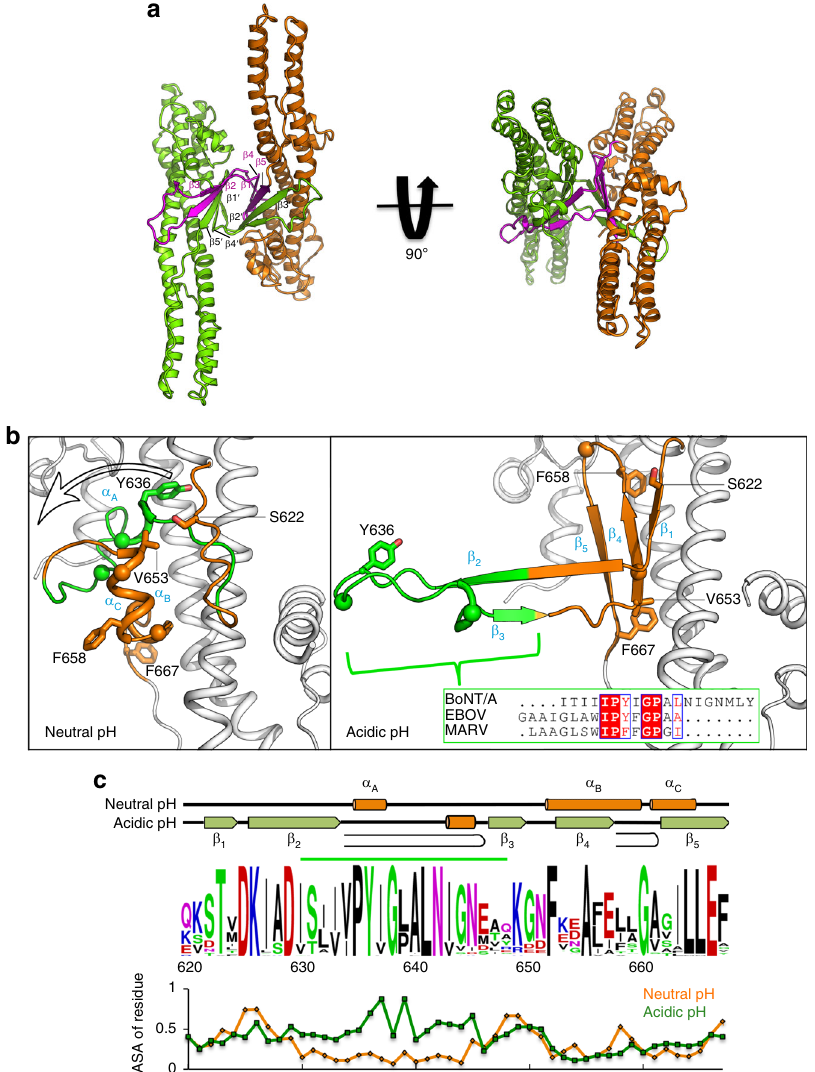
Fig. 2 Crystal structure of tH N A at an acidic pH. a Structure of a tH N A dimer (orange and green) observed in an asymmetric unit. The BoNT-switch of chain A is colored in magenta. b The structures of the BoNT-switch at neutral (left) and acidic pH (right). The β 2/ β 3 loop is highlighted in green. Residues discussed in the text are shown as sticks, C α atoms of conserved glycines are drawn in spheres. (Boxed) Sequence alignment of the β 2/ β 3 loop and the internal fusion loops of Ebola virus (EBOV) and Marburg virus (MARV) glycoproteins were generated with ESPript 3.0. c Amino acid sequences of E620- F667 (BoNT/A1 numbering) from 42 BoNT subtypes 8 , TeNT, BoNT/X, and eBoNT/J were aligned (Clustal Omega) and depicted as sequence logo. Individual sequences are shown in Supplementary Fig. 6. The secondary structure of the BoNT/A1-switch at neutral and acidic pH is shown on the top. The β 2/ β 3 loop is underlined in green. The solvent-accessible surface area (SASA) of the corresponding residues is shown at the bottom. SASA was calculated using the program POPS 42 . The SASA values are for the entire residue and represent fraction of exposed surface